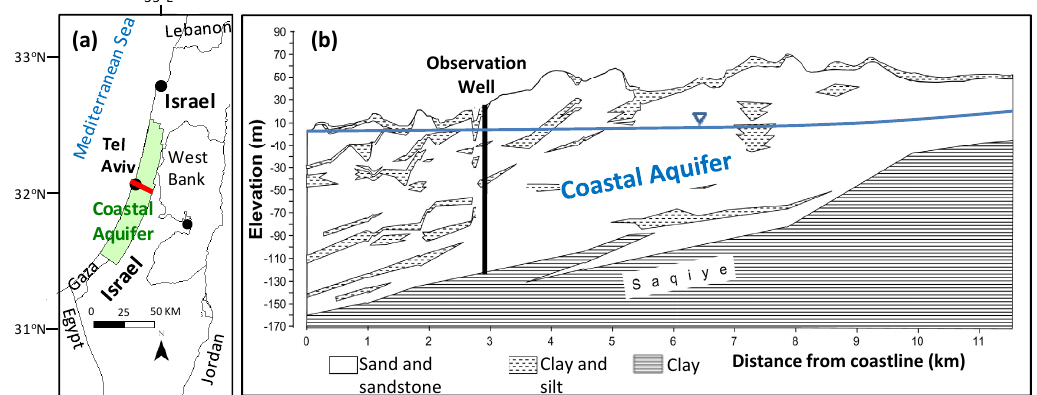
Fig. 1. (a) Location map of the Israeli Coastal Aquifer (green). A cross section (red line) through the Tel Aviv metropolitan area is shown in (b) . (b) East-west cross section of the aquifer, and the location of the observation well.